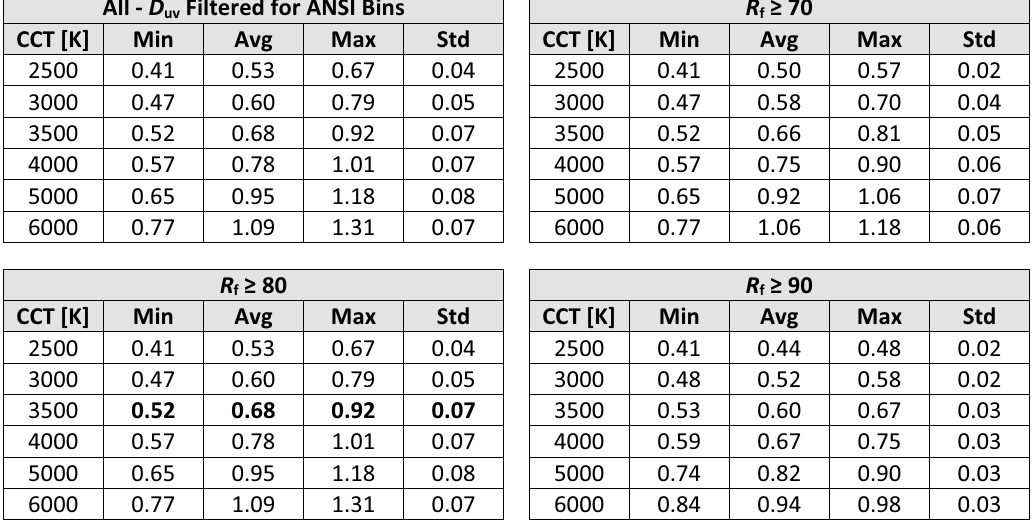
Table 1. Statistical summary of melanopic daylight efficacy ratio 26 for SPDs with various fidelity ( R f ) filtering. This table can be used as a quick reference to gauge the magnitude of mel-EDI for an SPD based on its nominal CCT and IES TM-30-20 R f . For example, a light source with a CCT of 3500 K and R f near 80 will have an mel- DER between 0.52 and 0.75; See bolded values in